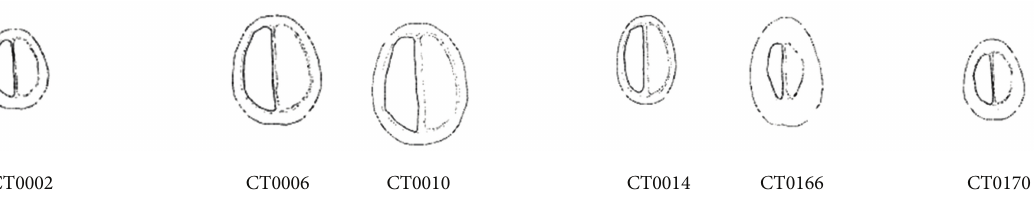
Figure 14: AUTO CAD simulative spline curve.